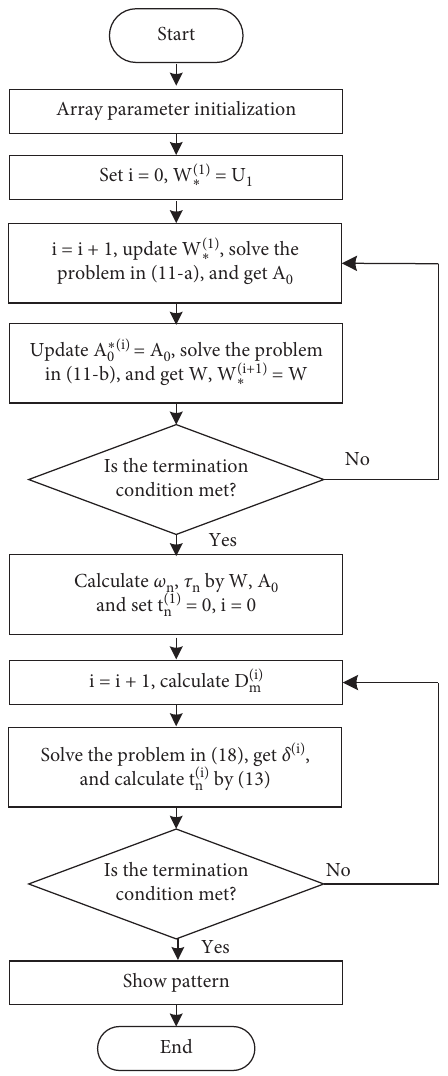
Figure 4: Flow chart of the proposed